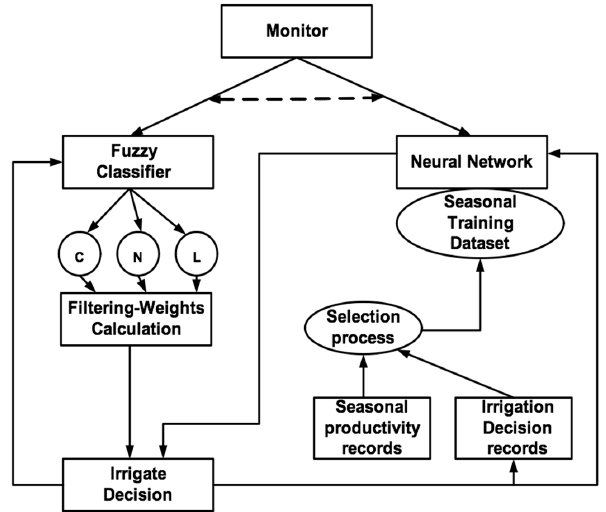
Figure 3. FITRA algorithm operation block diagram.